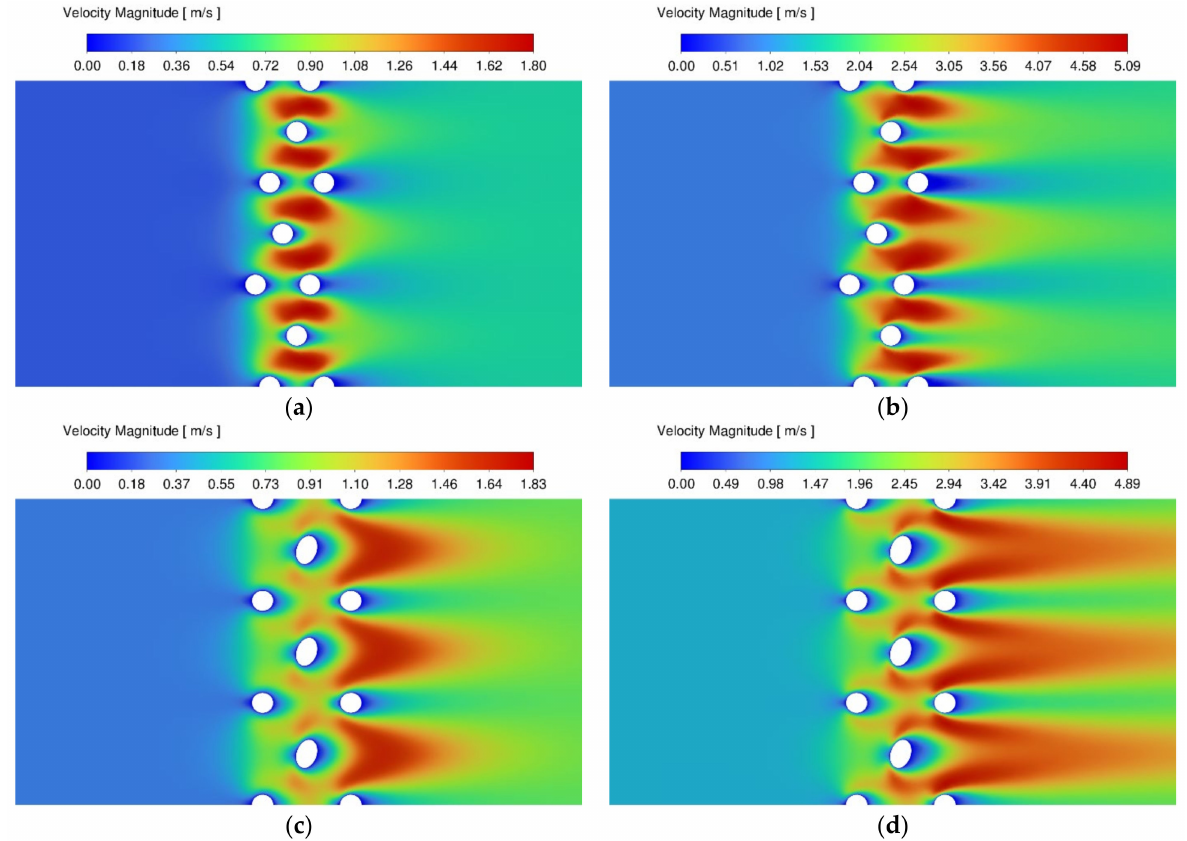
Figure 4. Velocity contours for: ( a ) Geometry A, contact time of 0.001 s; ( b ) Geometry A, contact time of 0.00025 s; ( c ) Geometry B, contact time of 0.001 s; ( d ) Geometry B, contact time of 0.00025